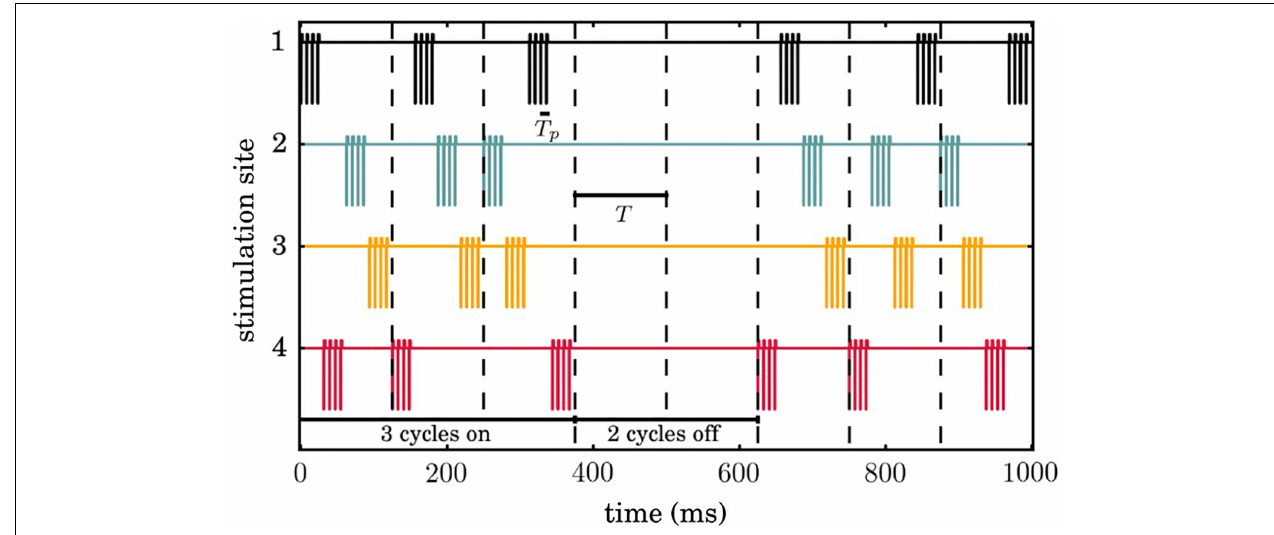
FIGURE 2 | Temporal evolution of coordinated reset (CR) simulation signals. Successive 3 ON and 2 OFF cycles are indicated by vertical dashed lines and the temporal distance between two successive vertical lines correspond to the period T of each cycle. Each stimulation site is activated exactly once during an ON cycle, where the sequence of activation across stimulation sites is